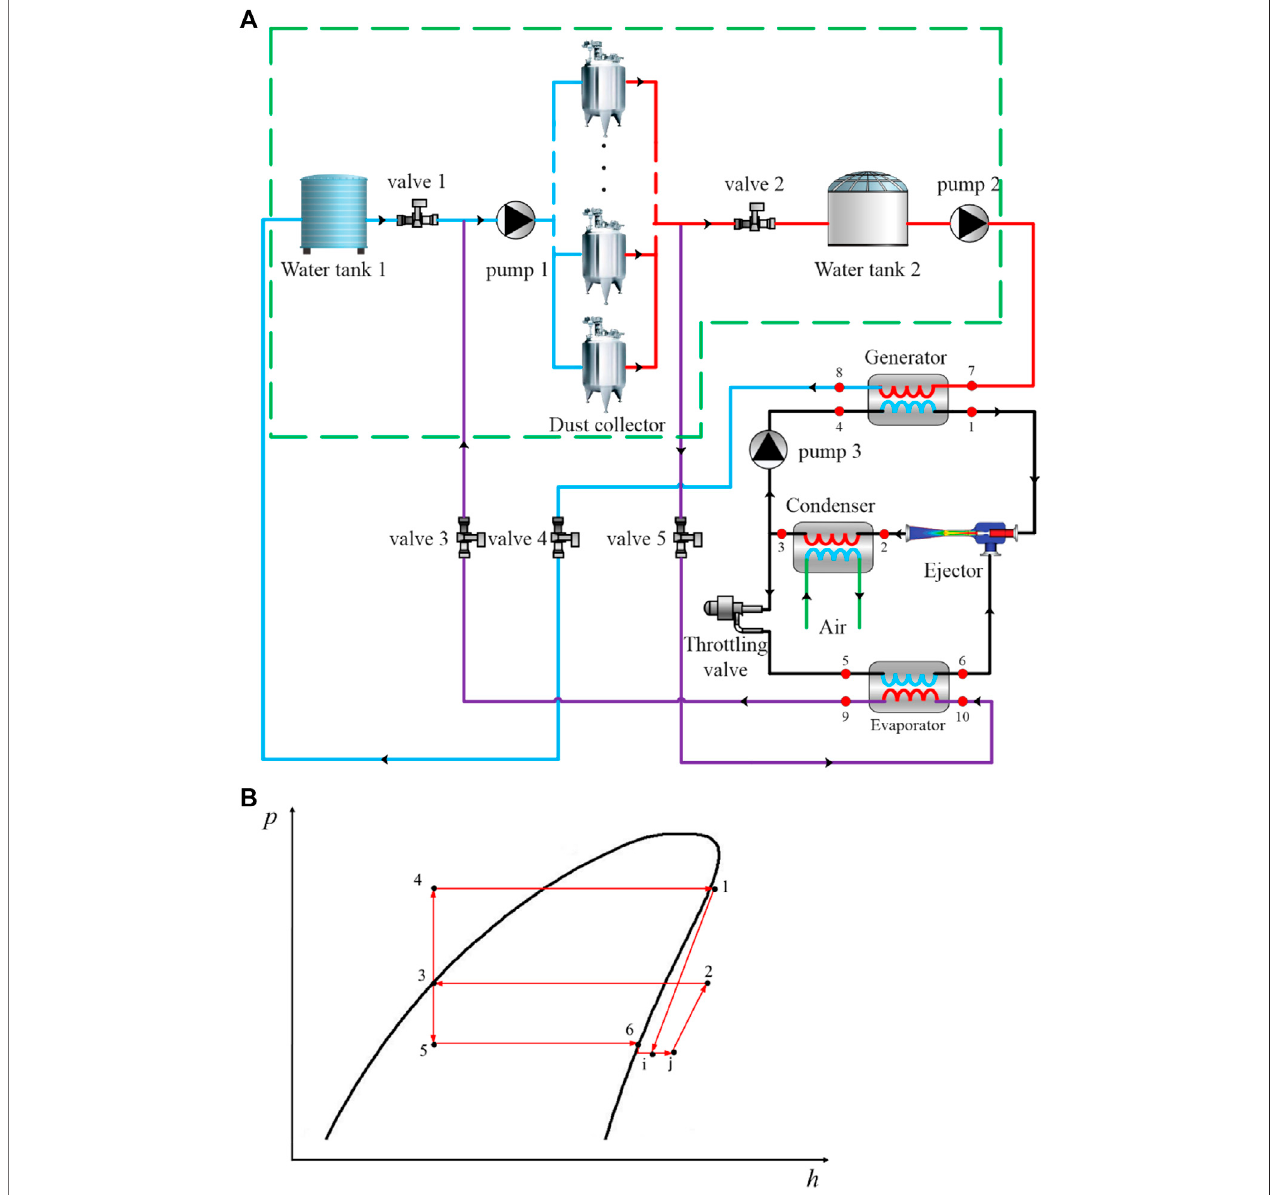
FIGURE 1 | Collector cooling system. (A) The schematic diagram; (B) p – h